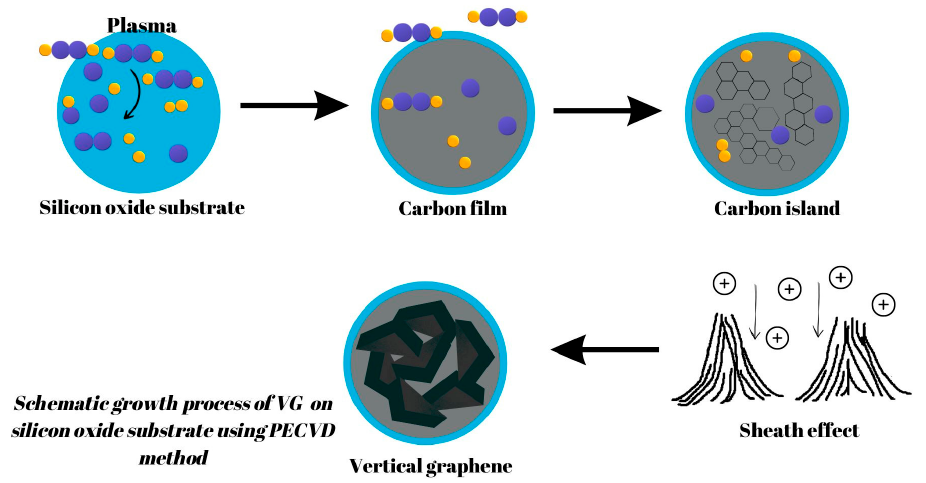
Figure 4. A schematic growth process of VG on a silicon oxide substrate using the PECVD